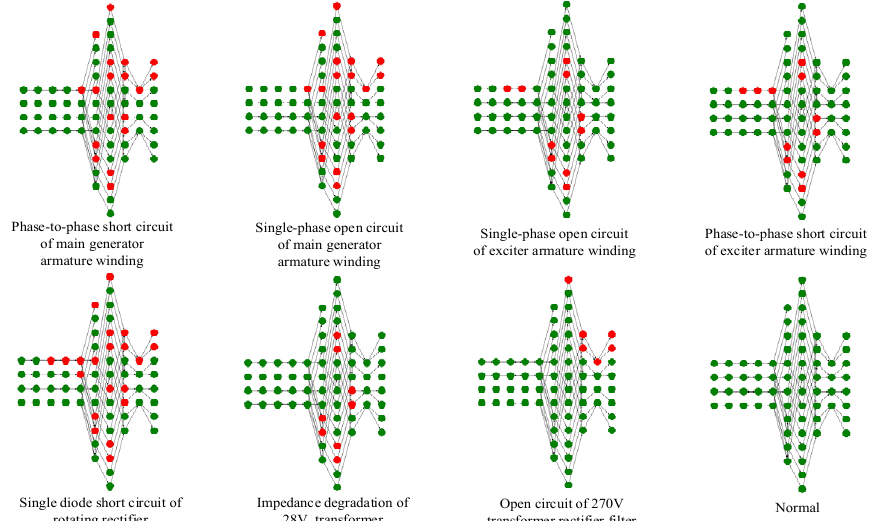
Figure 8. Detection results of associated faults of typical power supply